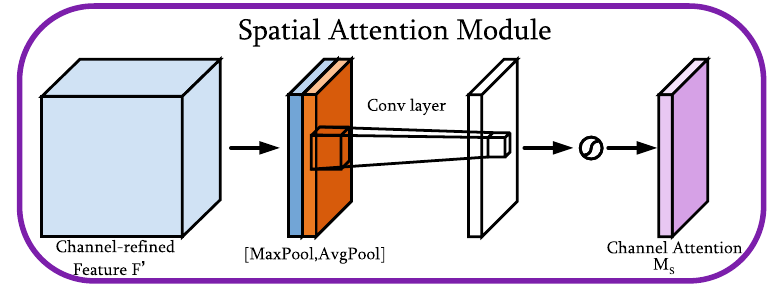
Figure 8. Diagram of spatial attention